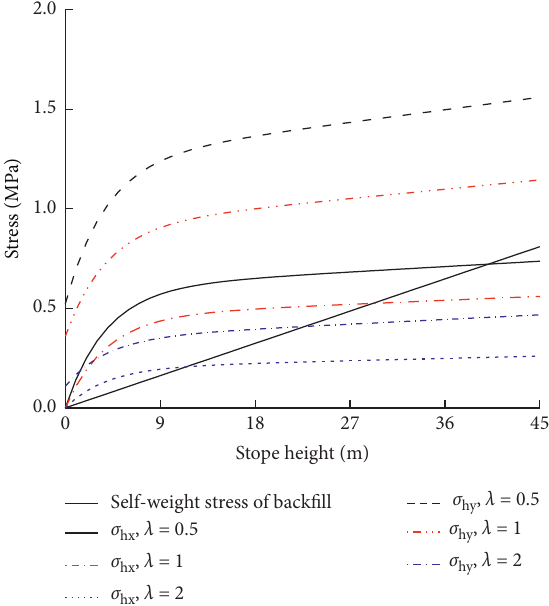
Figure 15: Lateral earth pressure effect on time-dependent stress profile of backfilling.